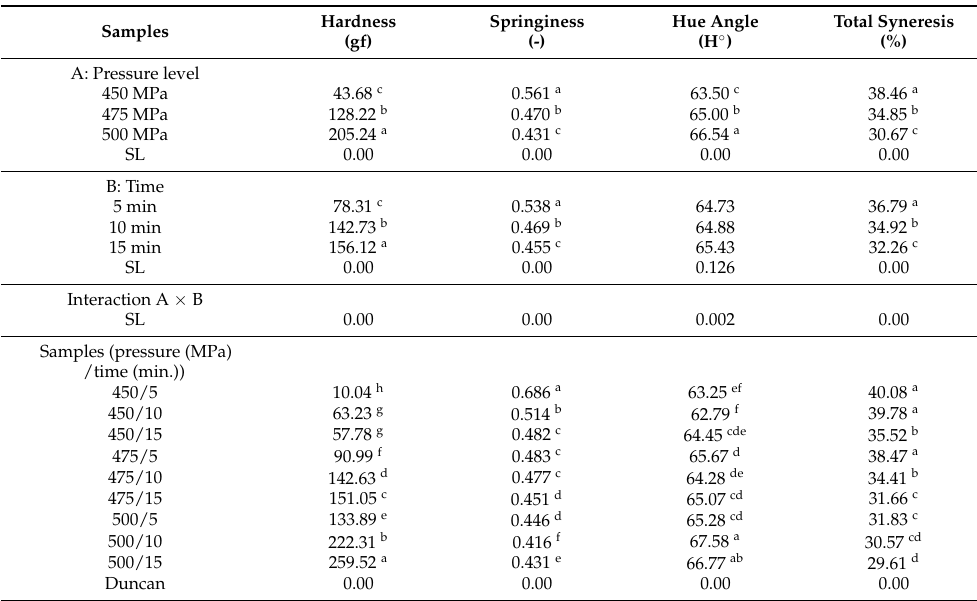
Table 1. The effect of different high-pressure levels and holding times on physical properties of strawberry-flavoured egg-white pudding. Samples Hardness (gf)